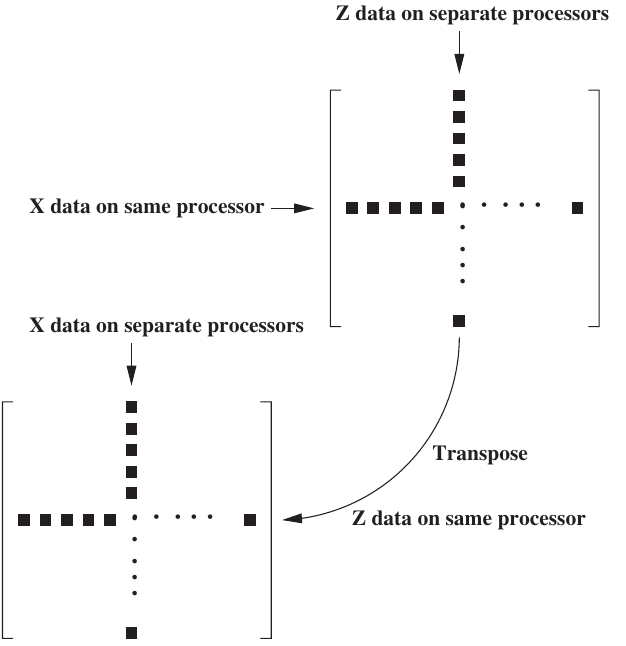
Fig. 1. The data are transposed back to its original position